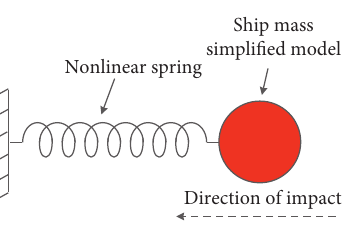
Figure 9: Simplified model of the barge impact rigid wall model.